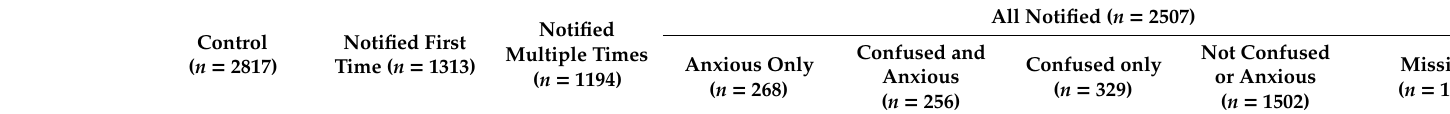
Table 4. Descriptive summary of women’s future screening intentions by breast density notification status (Controls ( n = 2817), Notified for first time ( n = 1313) and Notified multiple times ( n = 1194)) and self-reported psychological reaction to notification for all notified women (Anxious only ( n = 268), Confused and anxious ( n = 256), Confused only ( n = 329), and Not confused or anxious ( n = 1502))